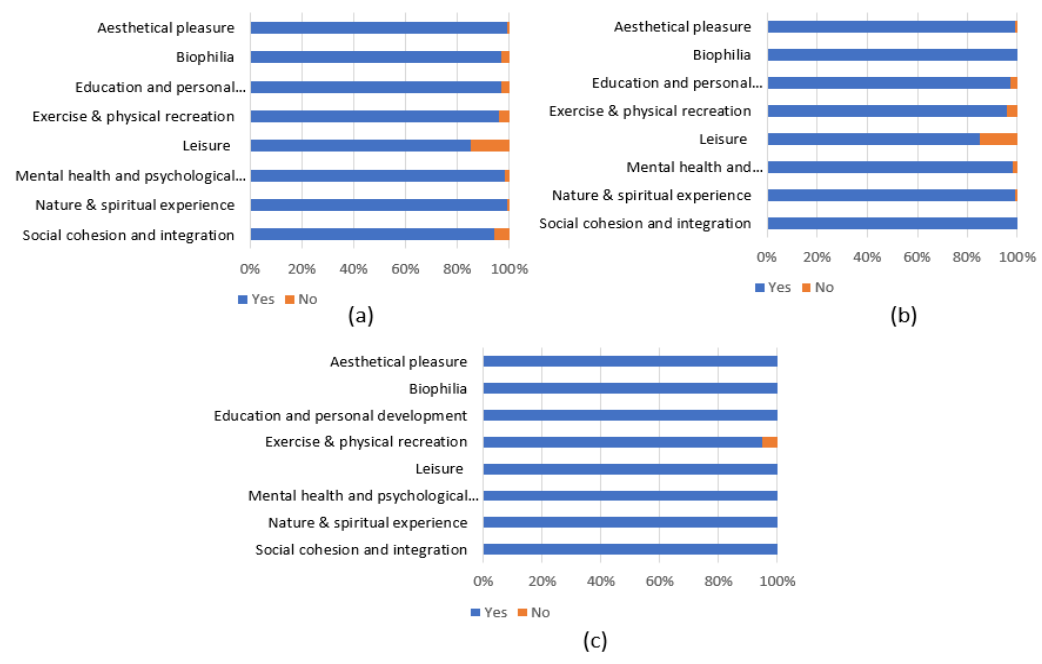
Figure 4. Cultural ecosystem services perceived by ( a ) seasonal crop farmers, ( b ) coffee farmers, and ( c ) nurseries.